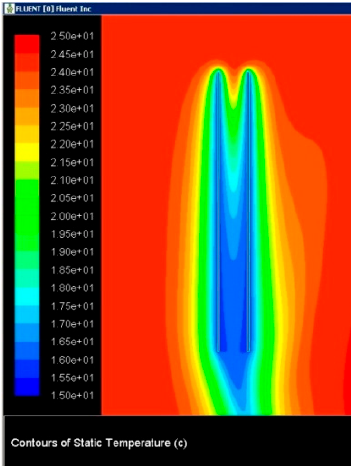
Figure 15. The contours of temperature (°C) at spacing of 7 mm and rib height 70 mm.